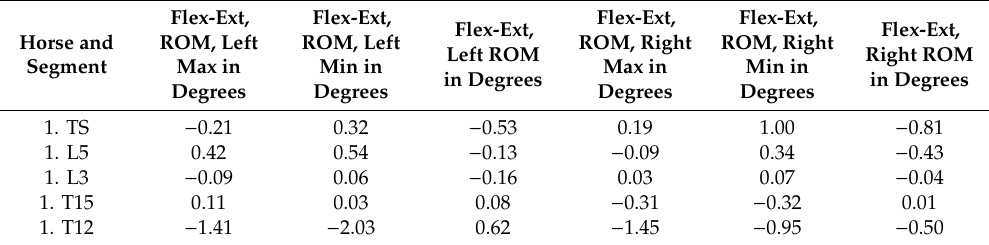
Table 3. Di ff erences in degrees in ROM of flexion-extension (flex-ext) between taped and non-taped runs in eight horses at five segments (Tuber Sacrale (TS), 5th Lumbar segment (L5), 3rd lumbar segment (L3), 15th Thoracic segment (T15), 12th Thoracic segment (T12) and “The whole back” (WB), no statistical significance was shown across all horses. Left / Right Max / Min are the symmetry parameters for the vertical displacement that show the di ff erences between the two extremes of the movement, each step results in one upward and one downward movement between the right and left halves of a stride. Values in bold shows the tendencies of increased